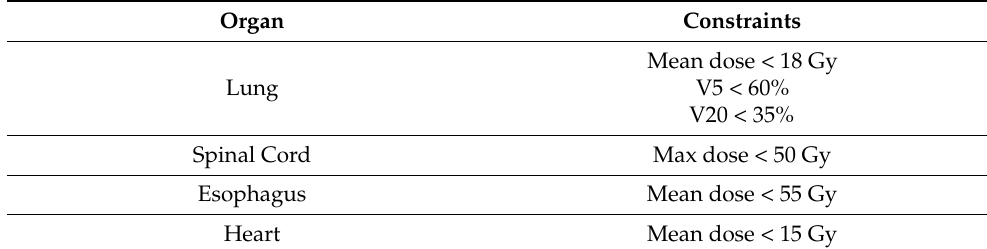
Table 1. DVH constraints for organs at risk.